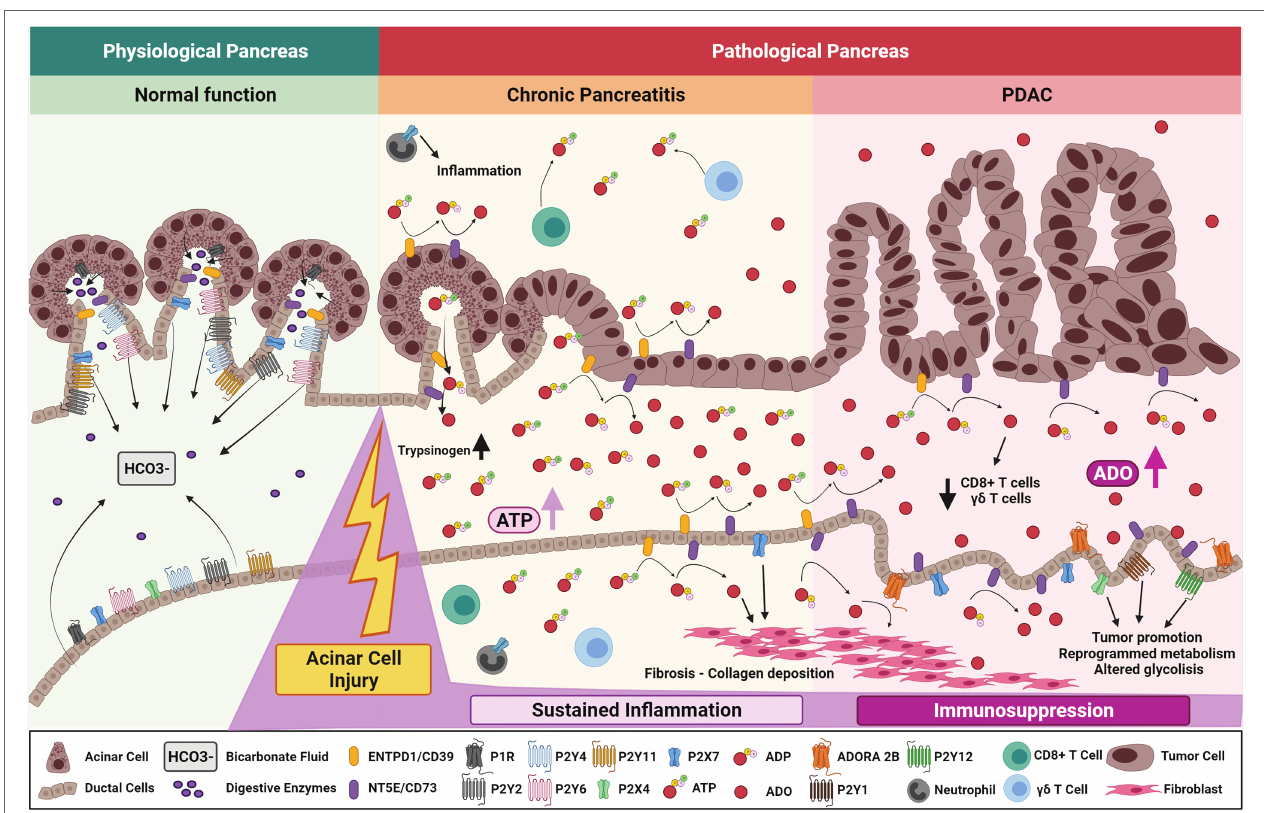
FIGURE 3 | Purinergic signaling mechanisms in chronic pancreatitis and development of pancreatic cancer. Purinergic signaling mediates normal pancreatic function by regulating ductal P2Rs-dependent bicarbonate fluid release and acinar CFTR-dependent exocrine pancreatic secretion. After acinar cell injury, increased levels of ATP are secreted into the extracellular compartment primarily from acinar cells, increasing pancreatic trypsinogen levels and affecting normal pancreatic function. In time, sustained ATP-derived inflammation and adenosine generation stabilizes pancreatic chronic injury and/or ongoing pancreatitis. Increased expression of ductal CD73 elevates adenosinergic signaling triggering collagen deposition and further fibrotic development. Altered ductal cells undergo aberrant purinergic signaling though P2Rs affecting glycolytic metabolism and cumulative pancreatic ADO signaling promotes CD8 + T cell and ϒδ T-cell depletion. These factors promote an immunosuppressive environment ultimately priming the organ to malignant transformation, PDAC initiation, and